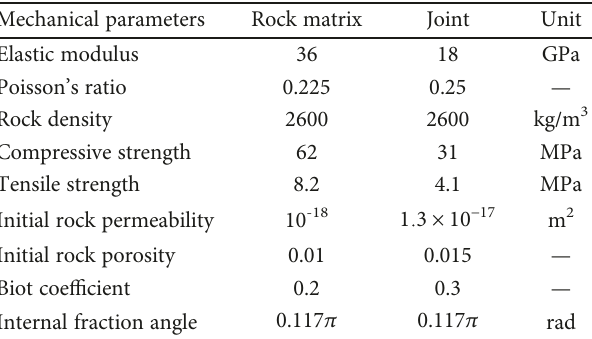
Figure 2: Numerical samples with di ff erent kinds of joints: (a) intact sample, (b) sample with layered joints, (c) sample with vertical joints, and (d) sample with orthogonal joints. Table 1: Mechanical parameters for the